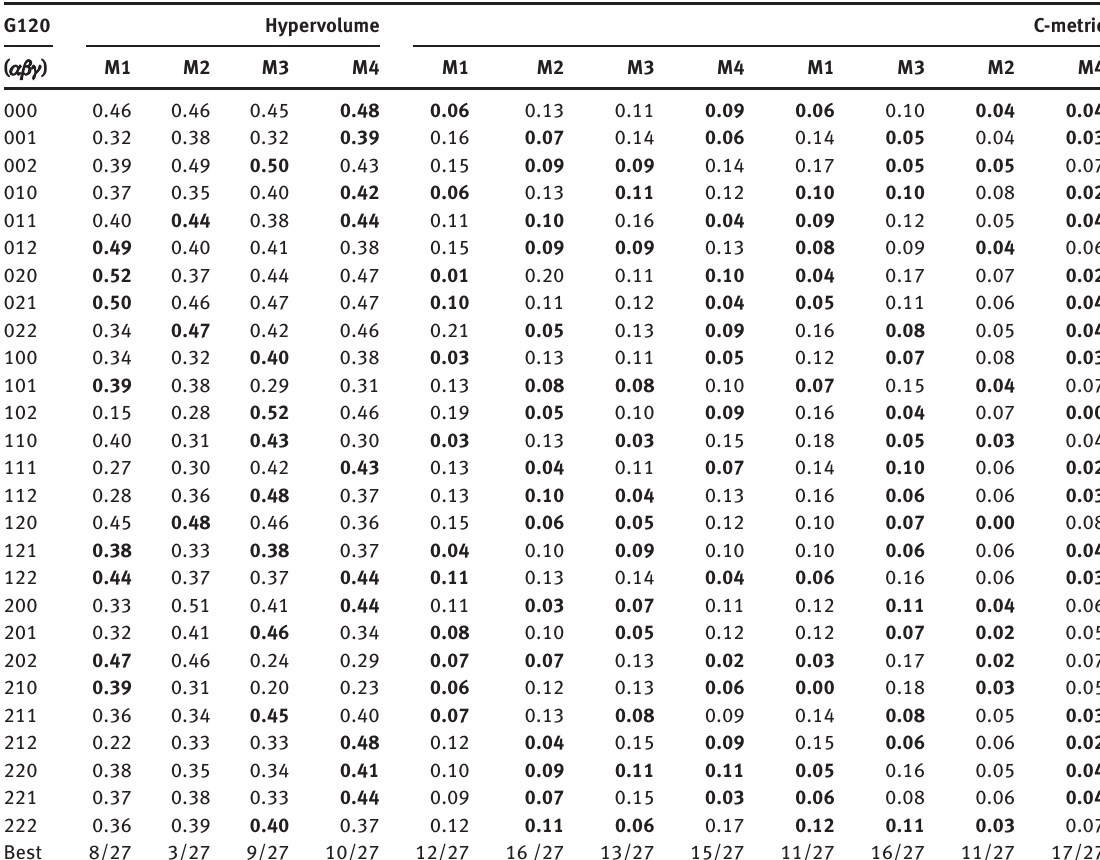
Table 6: G 120 – Hypervolume and C-metric.